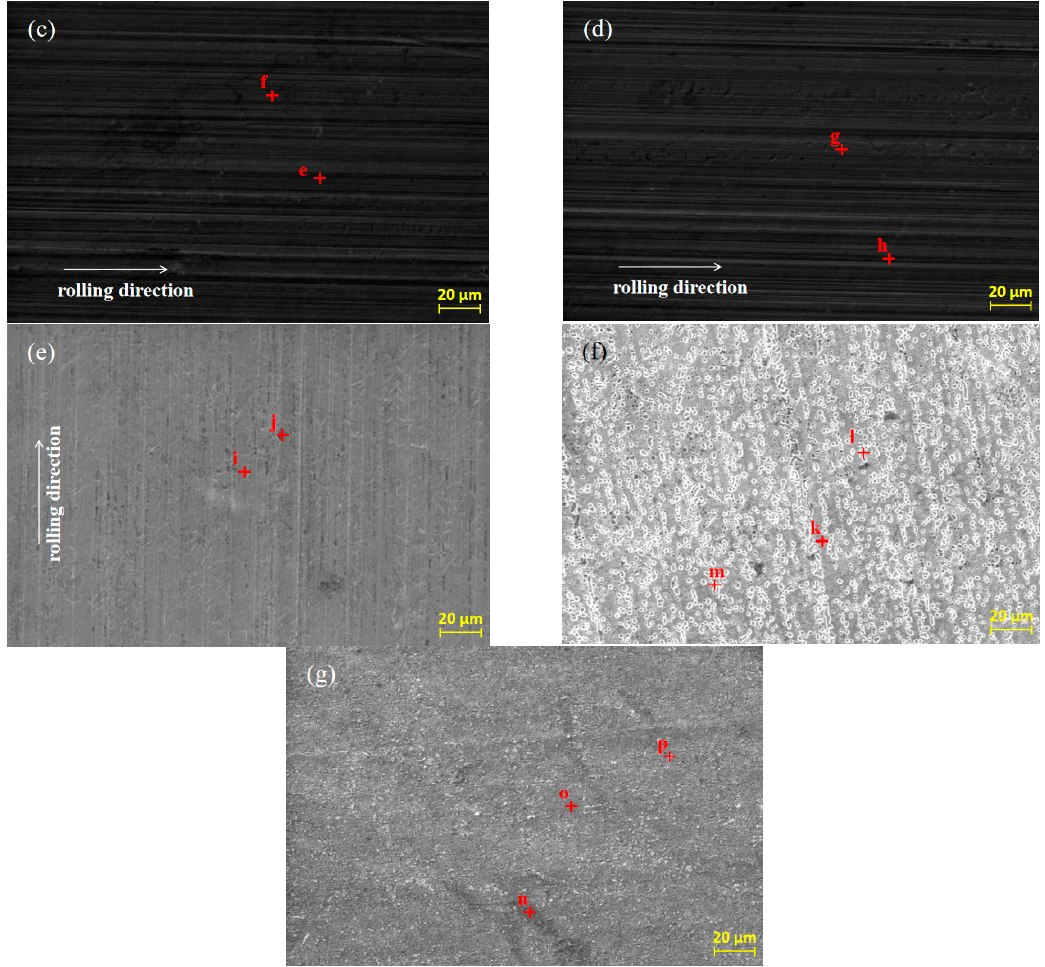
Figure 4. The original SEM morphology of the rolled copper foil ( a ) and its morphology after corrosion in conditions B ( b ), C ( c ), D ( d ), E ( e ), F ( f ) and A ( g ).